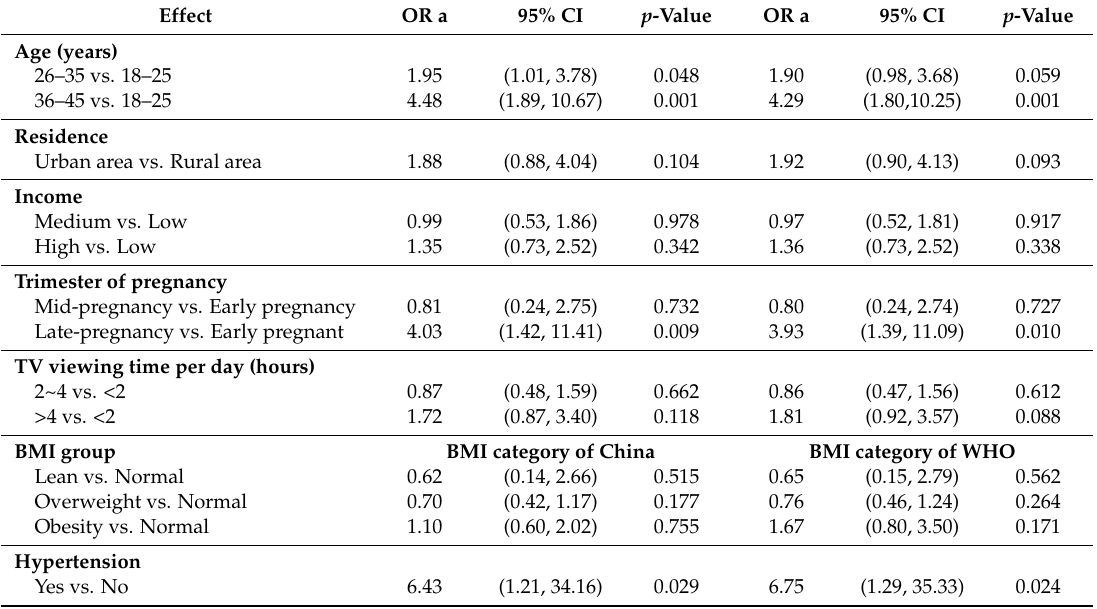
Table 3. Multivariable logistic regression analysis for the prediction of gestational diabetes mellitus, China.